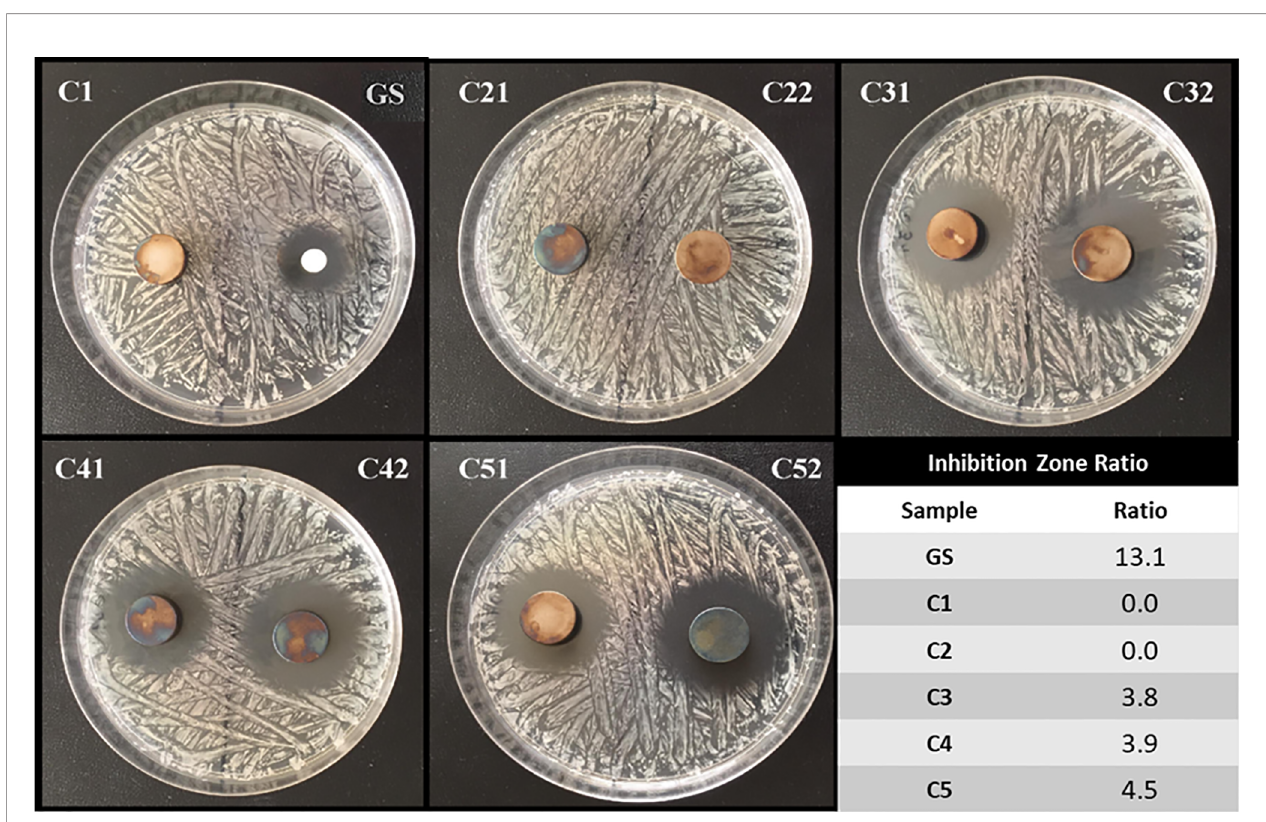
FIGURE 6 | Inhibition zones of Ti6Al4V